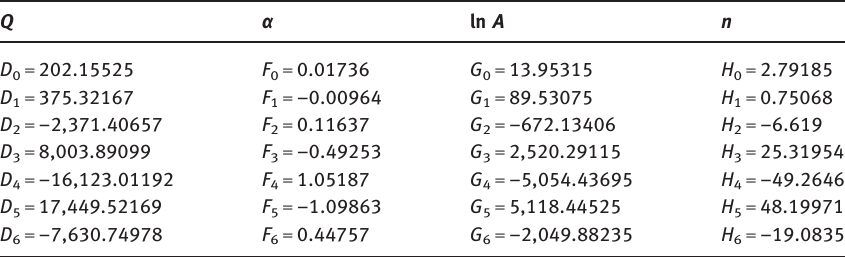
Table 3: Results of the polynomial fit of Q , α , ln A , and n for the β